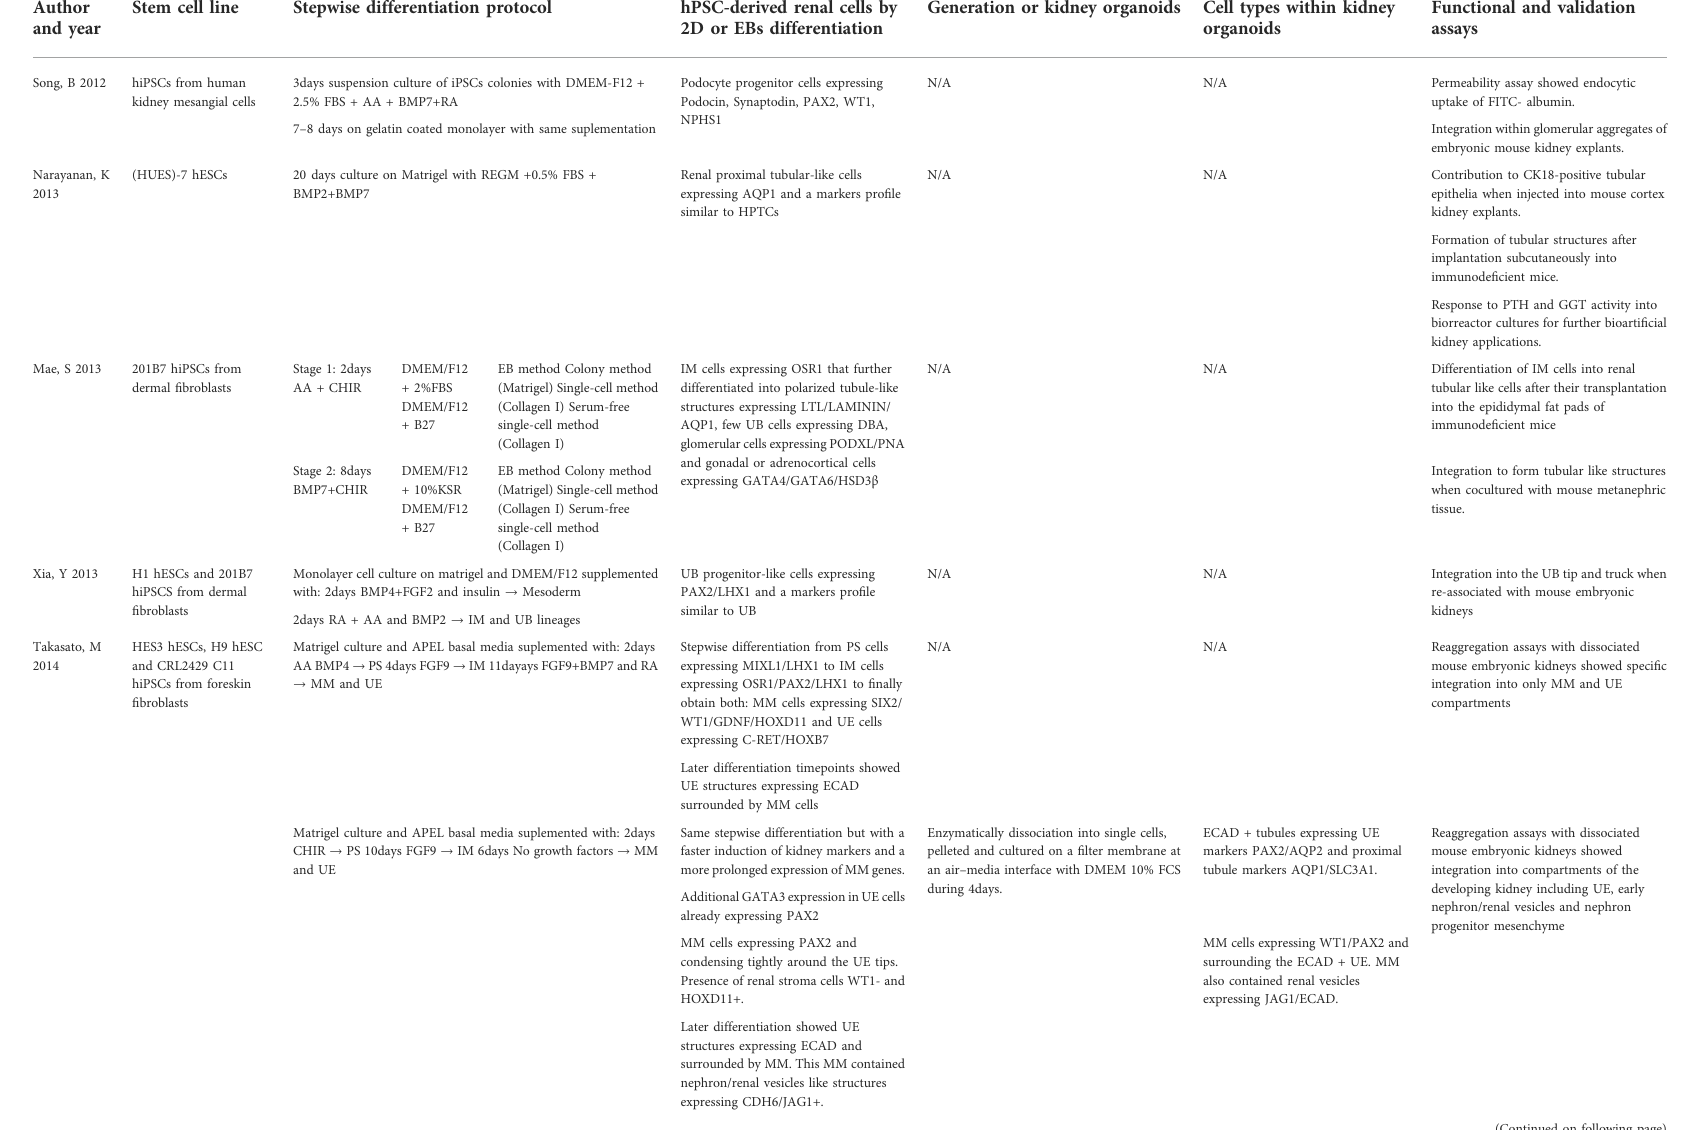
TABLE 1 Major approaches and protocols for directed differentiation of hPSCs into renal progenitor cells and kidney organoids. Author and